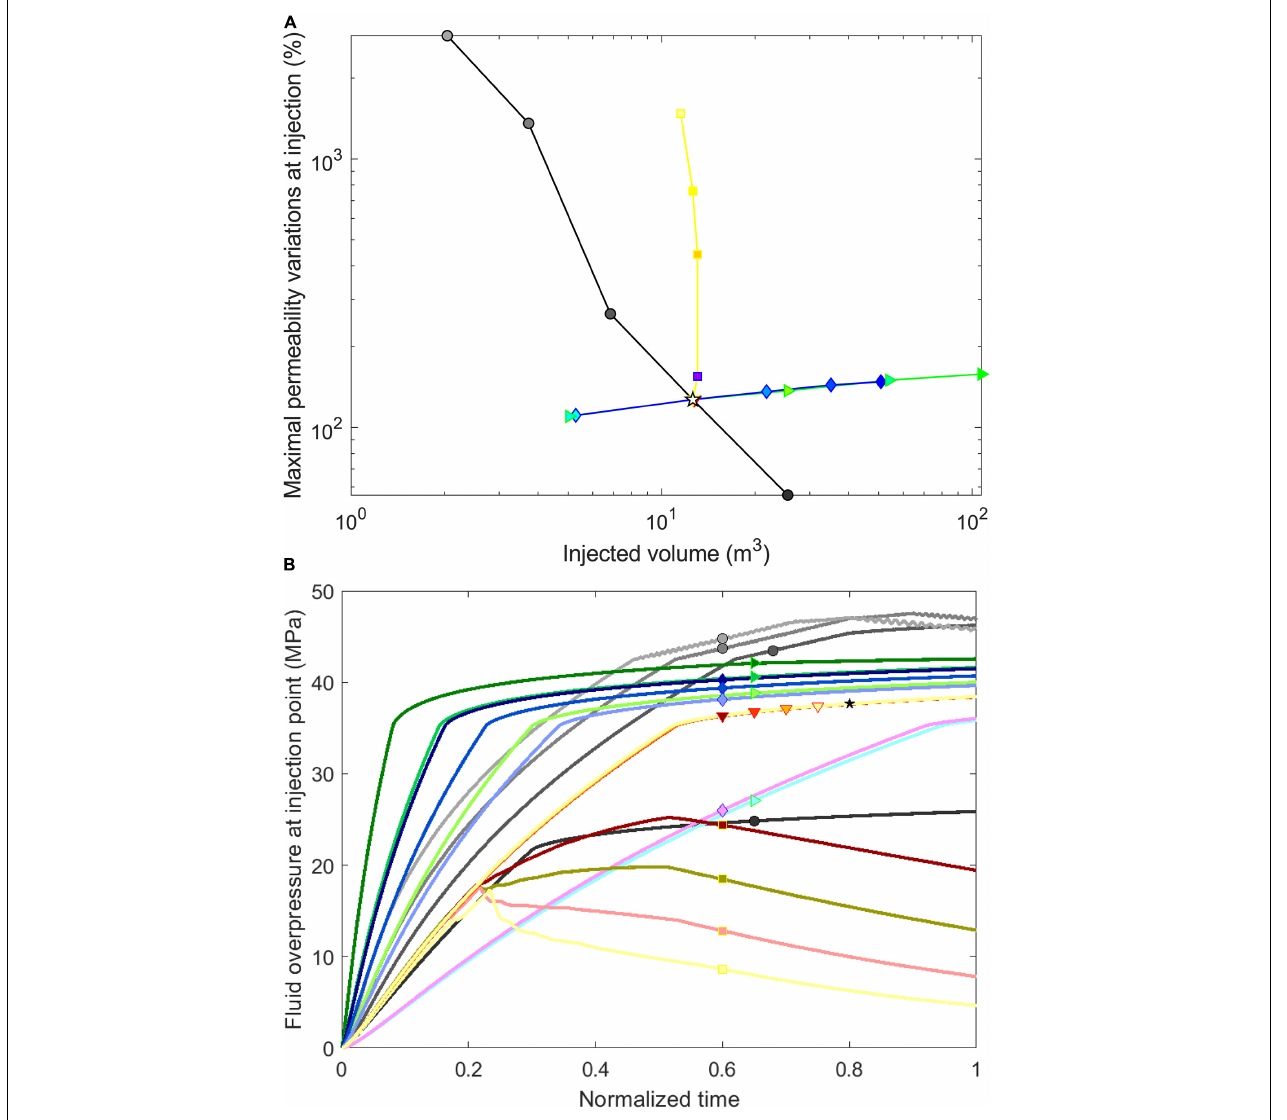
FIGURE 8 | (A) Maximal permeability variations at the injection point as a function of total injected fluid volume for the 21 simulations ( Table 2 ). Injection tests with a same varying parameter are linked by a single-colored line. Each test is defined by a color and a symbol. The reference case is represented by a star. (B) Fluid overpressure at injection point as a function of normalized time for the 21 simulations ( Table 2 ). Each test is defined by a color and a symbol. The curves for the reference case, represented by a black star, and the critical slip test (down-pointing triangle symbol) are the